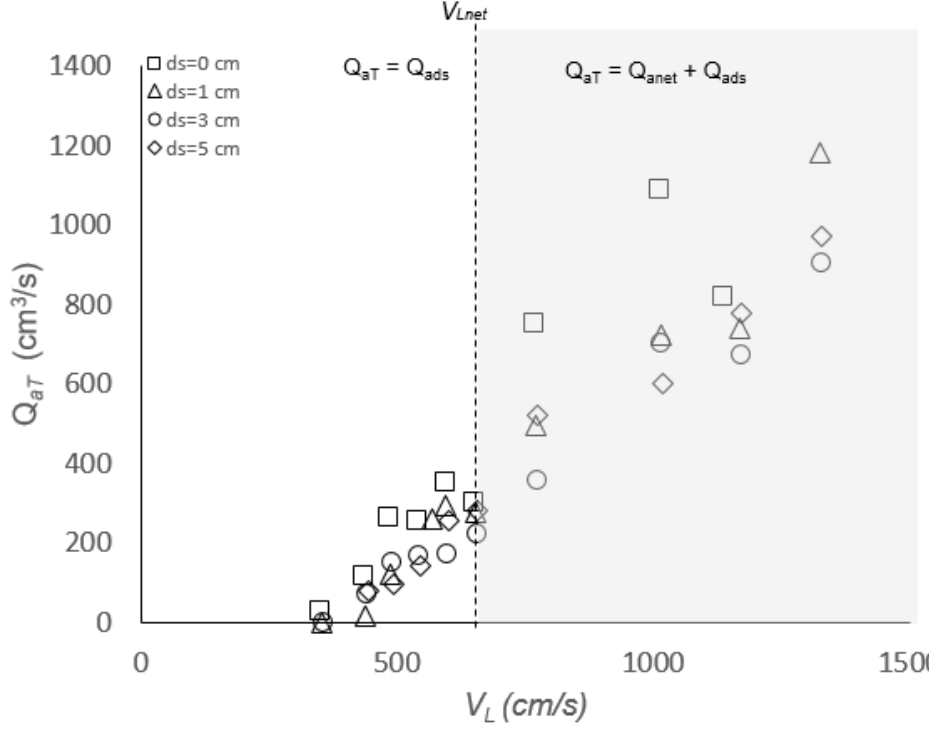
Figure 7. Total entrainment flow rates as d s increases from 0 to 5 cm for l ADR = 40 cm.